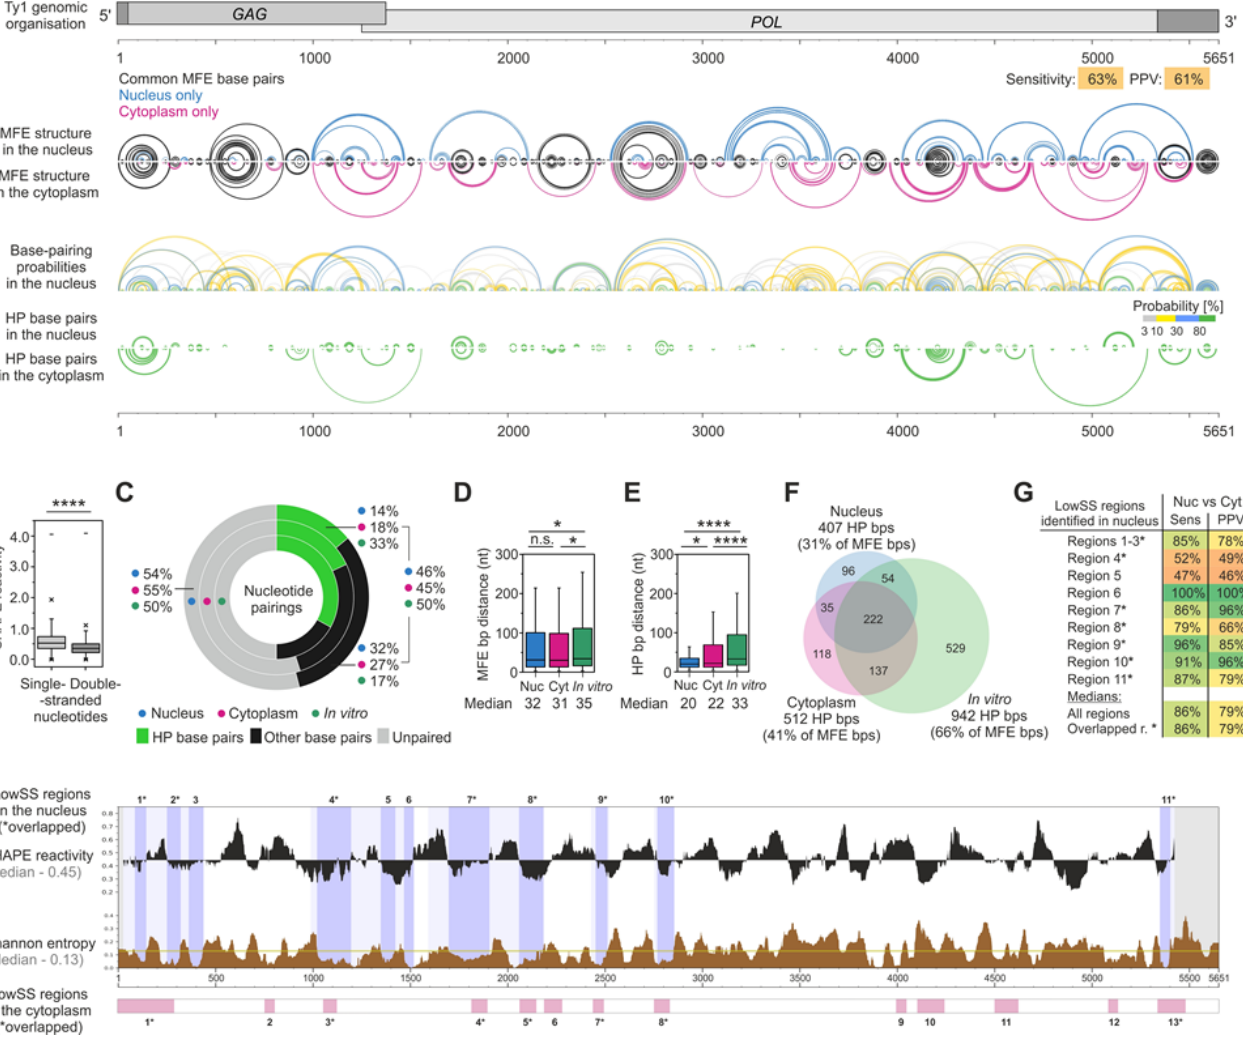
Figure 3. SHAPE-directed structure model of the nuclear Ty1 gRNA and its comparison with MFE structures predicted for cytoplasmic or in vitro Ty1 gRNAs. ( A ) Genomic organization of Ty1 gRNA. ( B ) Box plot analysis of SHAPE reactivities mapped to single- and double-stranded regions of the nuclear Ty1 gRNA MFE structure. ( C ) Pie chart analysis of percentage distributions of nucleotide pairings in the MFE structures, including high probability base pairs (HP bps, pairing probability > 80%). ( D ) Box plot analysis of MFE bps and ( E ) HP bps distance with medians. ( F ) Venn diagram showing overlap of HP bps. ( G ) Sensitivity and PPV parameters for lowSS regions identified in nuclear Ty1 gRNA. ( H ) LowSS regions analysis. Light shadings indicate extending to encompass entire intersecting helices from MFE structures. The bottom bars present locations of lowSS regions in the cytoplasmic Ty1 gRNA. Overlapped regions are marked by *. Significance was computed by unpaired two-tailed Mann – Whitney test; **** p < 0.0001. * p < 0.05; n.s., not significant.